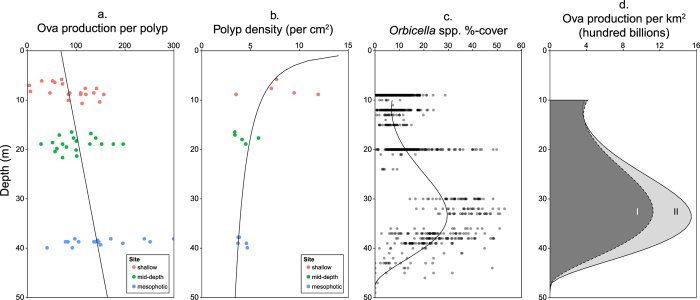
Regressions over depth of polyp fecundity, polyp-spacing, Orbicella spp. coral cover, and the resulting product which estimates the number of ova produced over a 1 km2 unit reef over depth.(a) A significant positive linear relationship was found between per polyp ova production and depth (p = 0.001, R2 = 0.18). (b) Mid-depth and mesophotic corals were found to have similar polyp-spacing, whereas shallow corals had significantly higher polyp densities (one-way ANOVA, p = 0.012, N = 15). A significant negative linear relationship was found after log transformation (p = 0.014, R2 = 0.381). (c) Third degree polynomial model of Orbicella spp. coral cover versus depth (p < 0.0001, R2 = 0.51). Orbicella spp. cover is used as a proxy for O. faveolata cover. (d) Expected Orbicella spp. reproductive output from hypothetical 1 km2 USVI reefs over depth. (I) Assumes equal polyp fecundity over depth27 (96 eggs per polyp32); (II) assumes empirically estimated depth-specific fecundity.